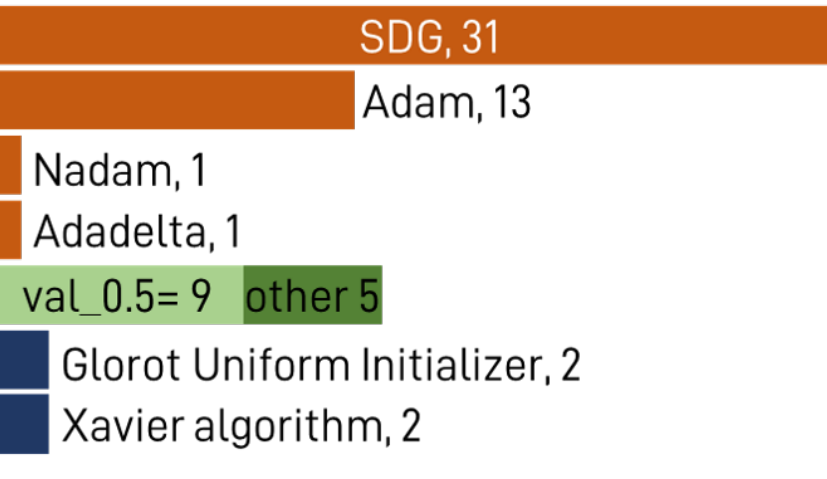
Figure 7. Distribution of optimizers used to fit the deep learning